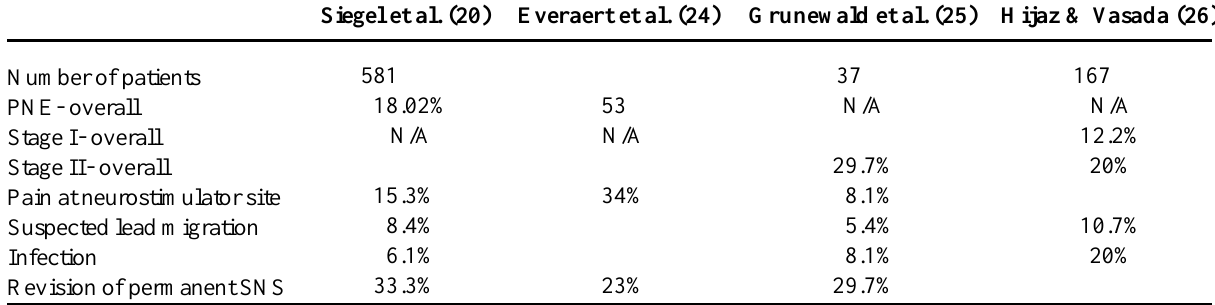
PNE = percutaneous needle